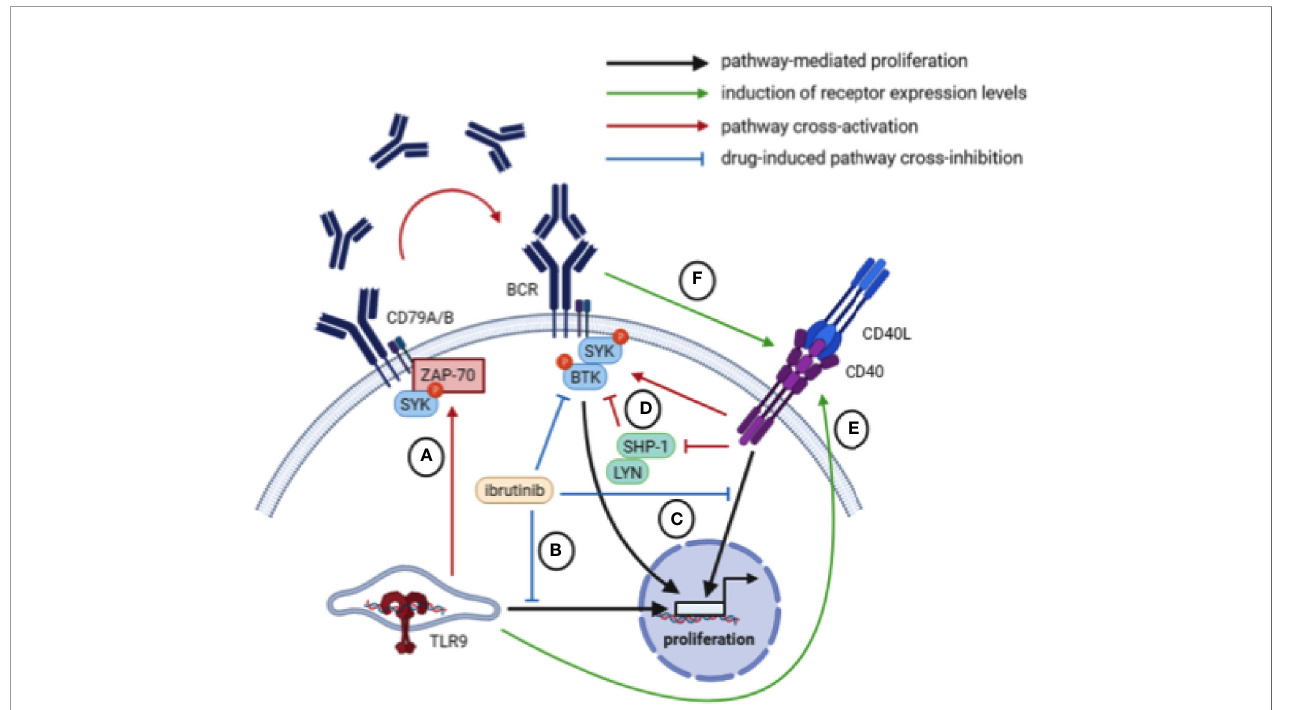
FIGURE 3 | Overview of potential crosstalk mechanisms between BCR, CD40, and TLR signaling. (A) TLR signaling in um-CLL may mount an autocrine feedback loop mediated by ZAP-70 and SYK involving the production and secretion of IgM which may subsequently trigger BCR signaling in an autocrine/paracrine manner. (B) Inhibition of BCR signaling via BTK inhibits CpG-mediated proliferation. (C) Inhibition of the BCR-associated kinases BTK or SYK inhibits CD40-mediated proliferation. (D) Upon CD40 stimulation, the BCR-associated kinases BTK and SYK are activated, possibly via inhibition of negative feedback components LYN and SHP-1. (E) TLR9 stimulation via CpG increases expression of the CD40 receptor. (F) Activation of BCR signaling increases expression of the CD40